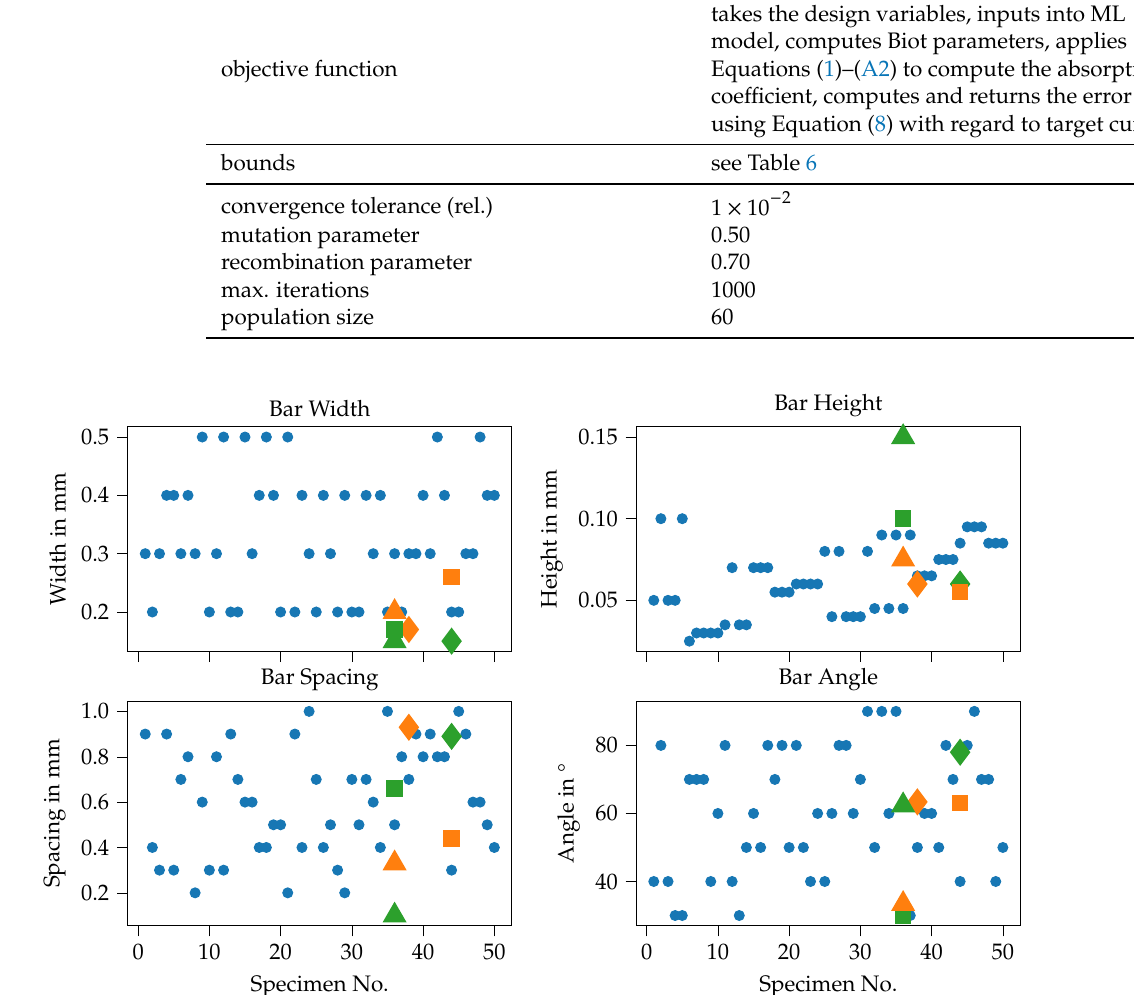
Figure A5. Overview over all designed Spec.s using the proposed ML approach. The colors refer to the ML model and the Spec. start population: Blue: basic population, Orange: KNN model, Green: ANN model. The symbols indicate the absorption coefficient target curve: ◆ : target curve “low”, ■ : target curve: “medium”, ▲ : target curve: